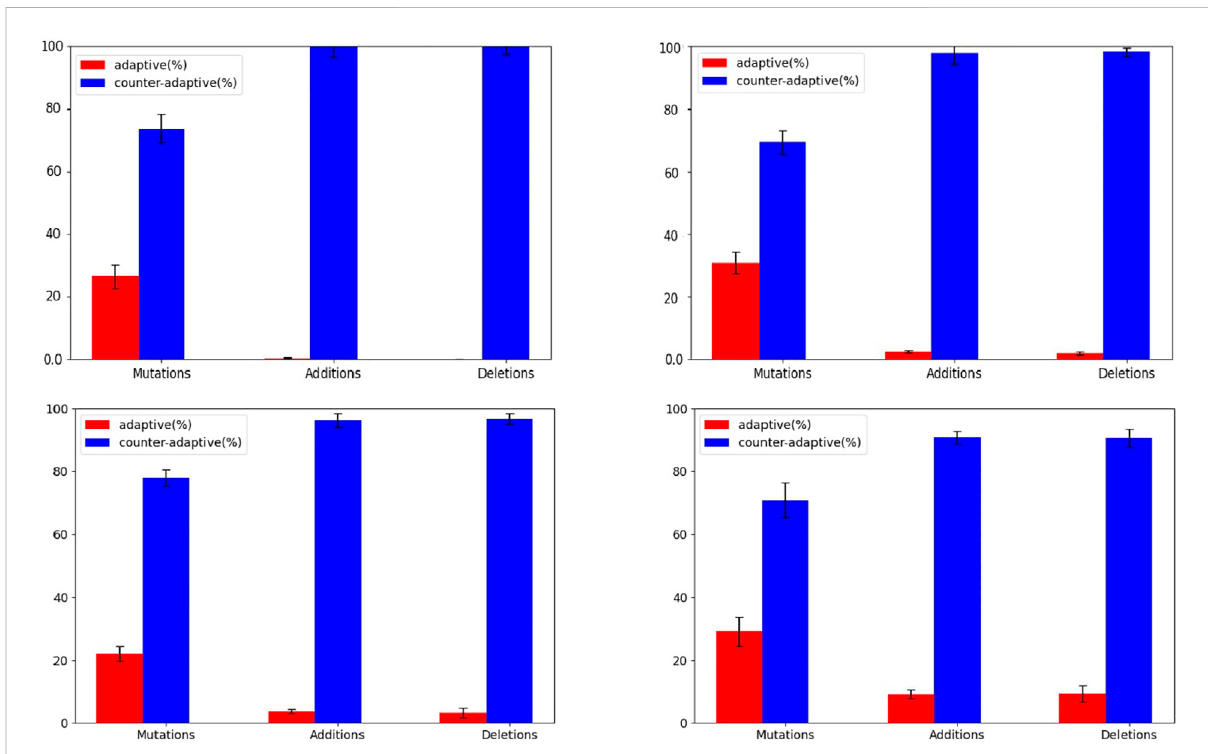
FIGURE 6 Fraction of adaptive and counter-adaptive value-change, addition, and deletion mutations. The top and bottom fi gures display the results obtainedwiththe(1+4)and(20+20)algorithms,respectively.Theleftandright fi guresdisplaytheresultsobtainedwiththestandardandcomplexity- biased algorithms, respectively. Data calculated on the best evolving individual of an intermediate generation, i.e. of the generation which corresponds to the half of the total number of generations. Data averaged over 20 individuals extracted from 20 corresponding replications of the experiment. The fraction of adaptive and maladaptive mutation is calculated by verifying whether the fi tness of the individual increases or decreases after the introduction of asingle value-changeor addition ordeletionmutation. For thisanalysisthe agents are evaluated for 10 episodes. Each individual is subjected to 1000 genetic variations of each kind. The fraction of neutral genetic variations is negligible.